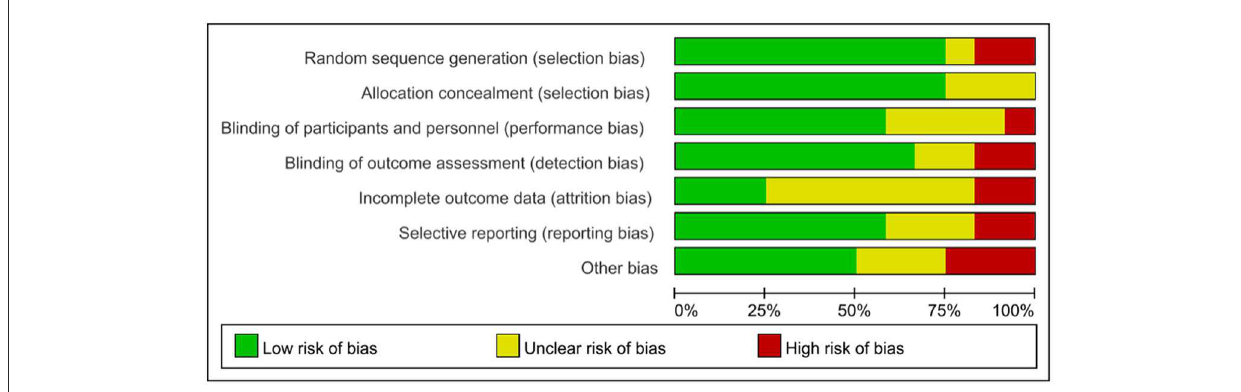
FIGURE2 Risk of bias graph of included studies.